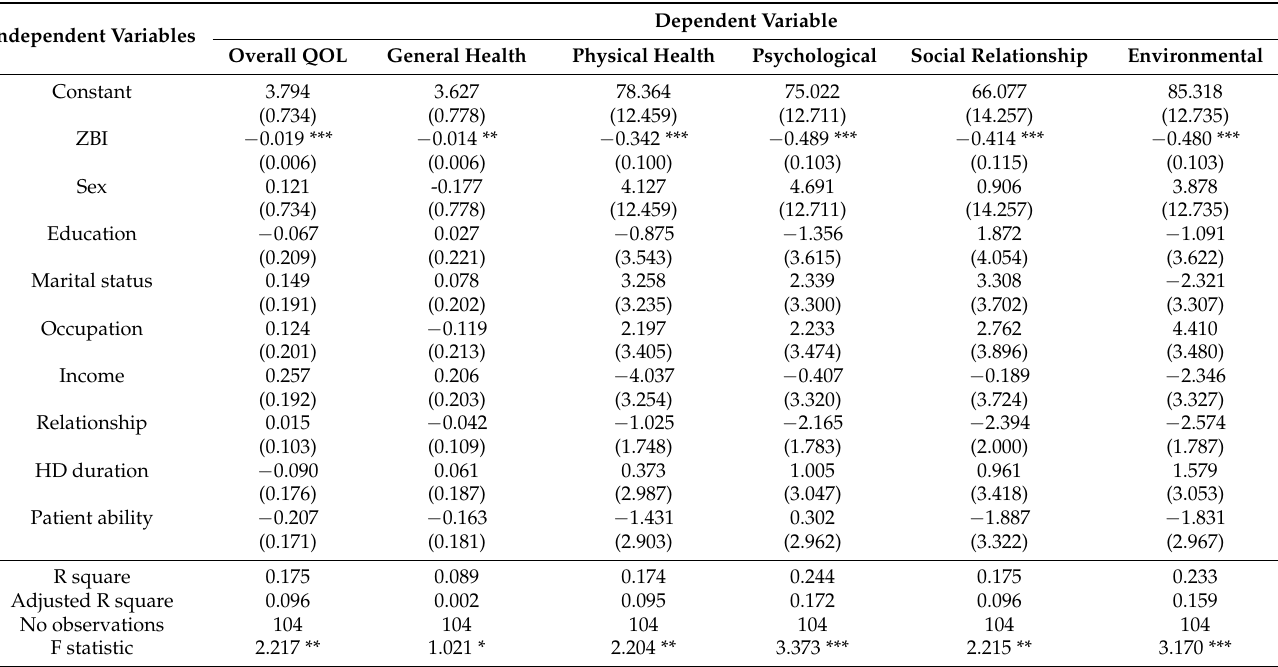
Table 4. Stepwise multiple linear regression analysis for burden and sociodemographic and clinical factors in relation to QOL.